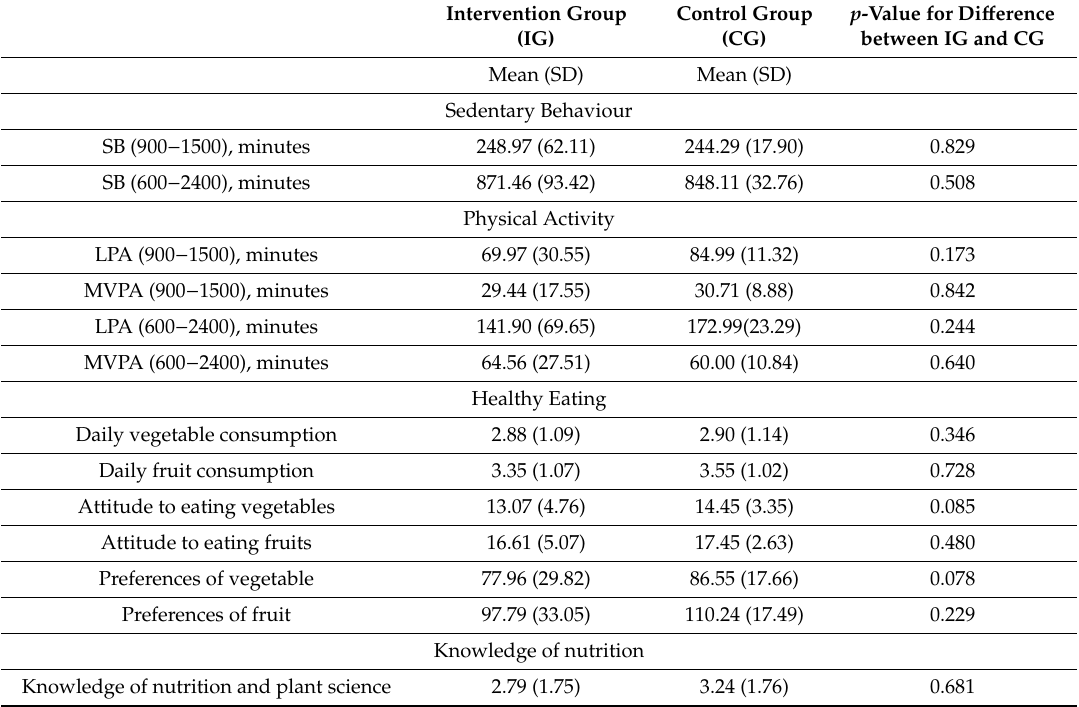
Table 4. Mean and standard deviation of the follow-up